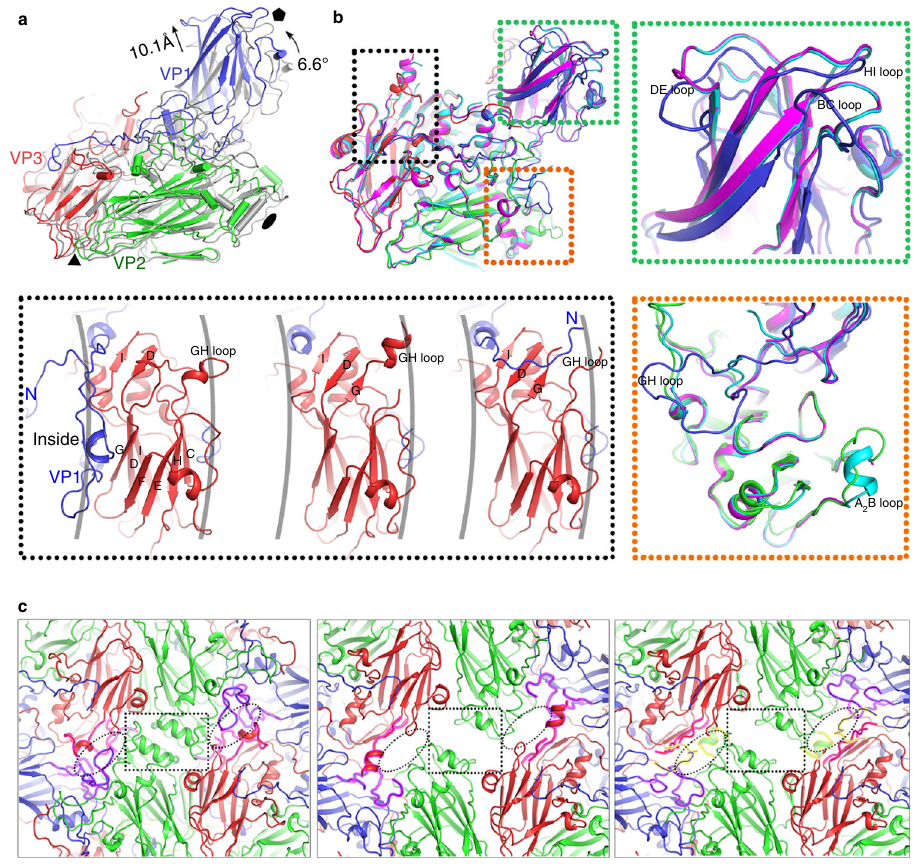
Fig. 3 Distinctions between the CVA10 mature virus, empty- and A-particles. a Protomeric units shown with respect to the icosahedral axes of the particles by superposing whole particles. The mature virus is shown in gray and the A-particle is colored as in Fig. 1c. The orientation is similar to that of the bright protomer in Fig. 1c; icosahedral symmetry axes are drawn in black. b Superposed protomers with structural differences highlighted in colored insets. VPs from CVA10 mature virus are colored using signature scheme; VPs of CVA10 empty- and A-particles are colored in magenta and cyan, respectively; noted for the larger black inset, signature color scheme applies to CVA10 mature virus (left), CVA10 empty particle (middle), and CVA10 A-particle (right). c Close-up views centered at twofold axes of the atomic models from CVA10 mature virus (left), empty particle (middle), and A-particle (right). The twofold channels (dotted rectangles) are closed (left), open (middle, right). The off-axis channels (dotted ellipses) are closed (left), unobstructed (middle), and obstructed (right). VP1 GH loop and VP3 GH loop are outlined in magenta (left, middle, right), VP1 N-terminus and VP2 A 2 B loop are outlined in yellow